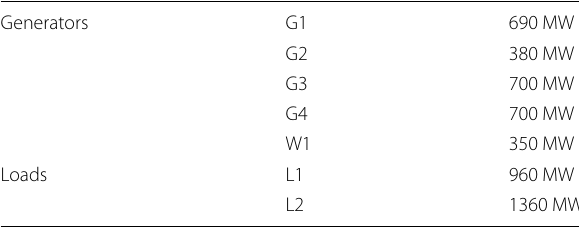
Table 1 The initial output active power of the generators and loads in the two-area power system